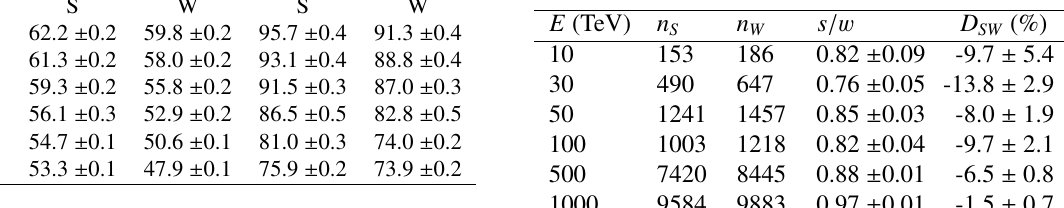
Table 5: Number of multi-muons events as a function of energy for summer ( n S ) and winter ( n W ), their ratio ( n S / n W ) and percentage di ff erence ( D SW ) between sum- mer and winter multi-muon events for θ = 50 ◦